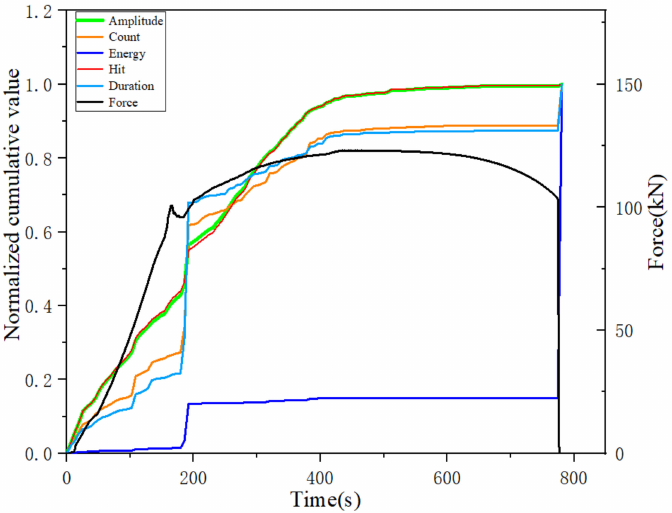
Figure 17. Variation of each normalized cumulative parameter at the loading rate of 1.5 mm/min.